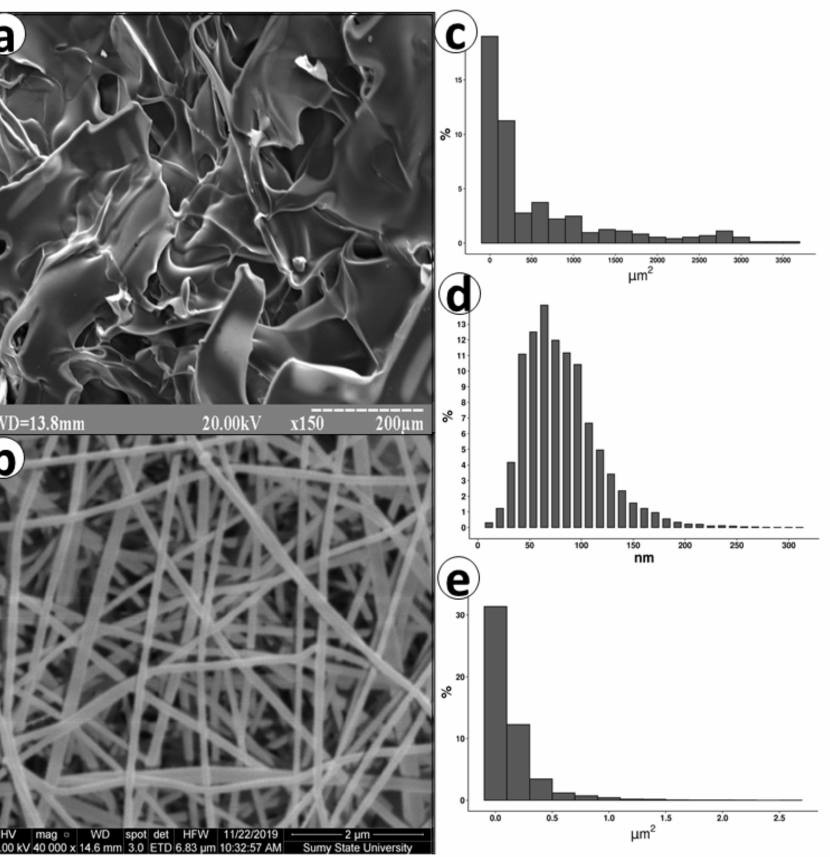
Figure 2. Scanning electron microscopy image of ChSp ( a ) with analysis of pore area ( c ). Structures ( b ), fiber diameter ( e ) and pore area ( d ) of